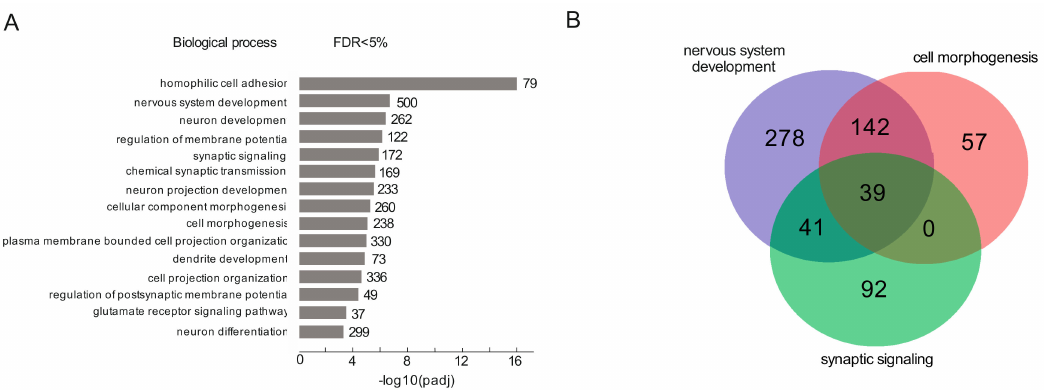
Figure 1. Search of rDNA-contacting genes for enriched Gene Ontology (GO) terms using g:Profiler. ( A ) The top 15 detected terms of biological processes associated with rDNA-contacting genes. The values to the right of bars show the number of rDNA-contacting genes associated with a term. The list of the corresponding genes is shown in Table S2. ( B ) The Venn diagram shows the intersections among rDNA-contacting genes associated with three terms (the list of the corresponding genes is shown in Table